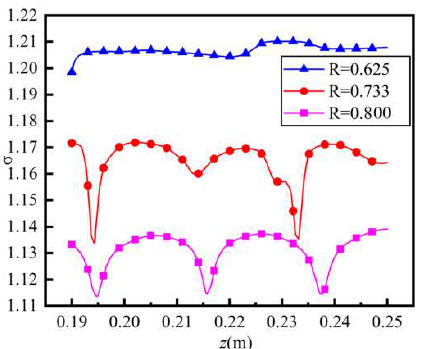
Figure 9. Distribution of particle diameter for different gap widths (cases 1–3 in Table 1). ( a ) geometric mean diameter,